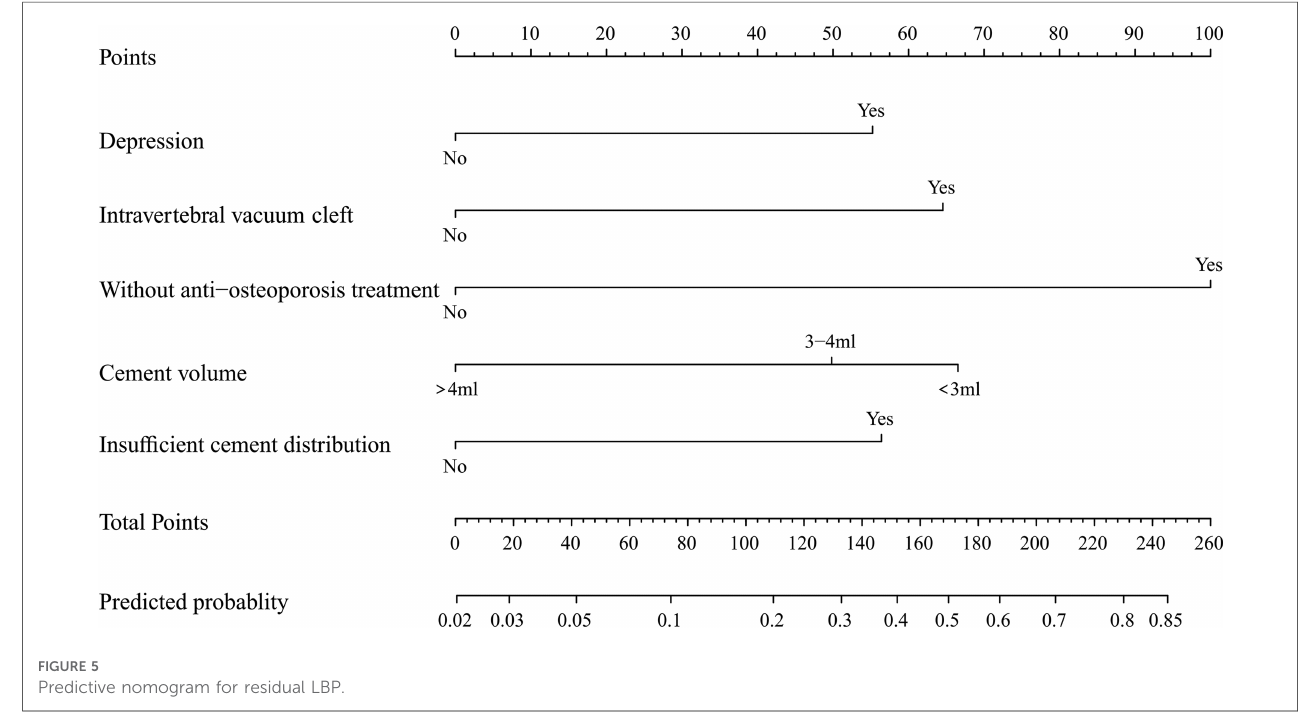
FIGURE 5 Predictive nomogram for residual LBP.